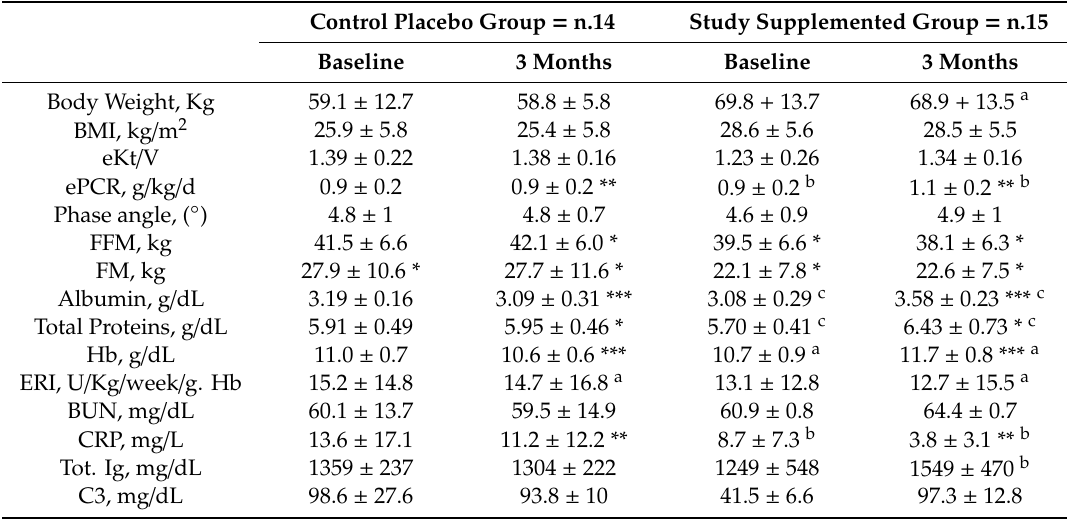
Table 3. Preliminary trial of a group taking AA supplementation compared to a placebo control group